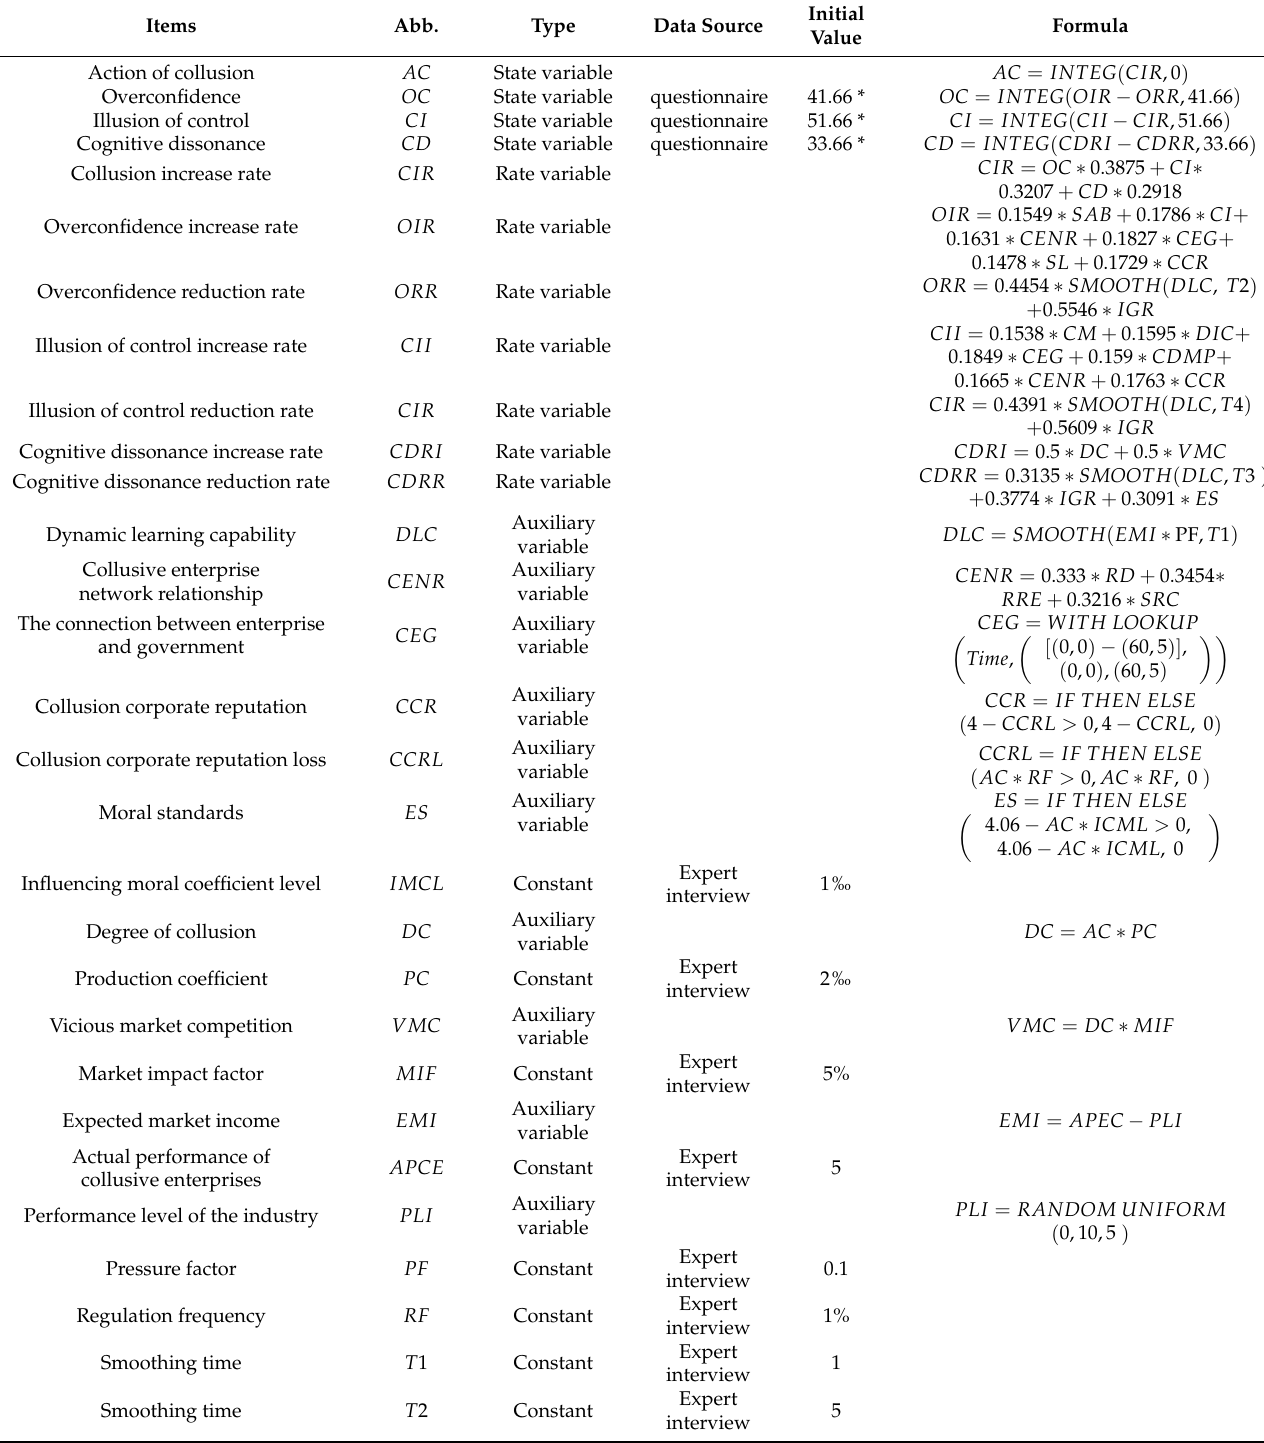
Table 4. Main items of the proposed